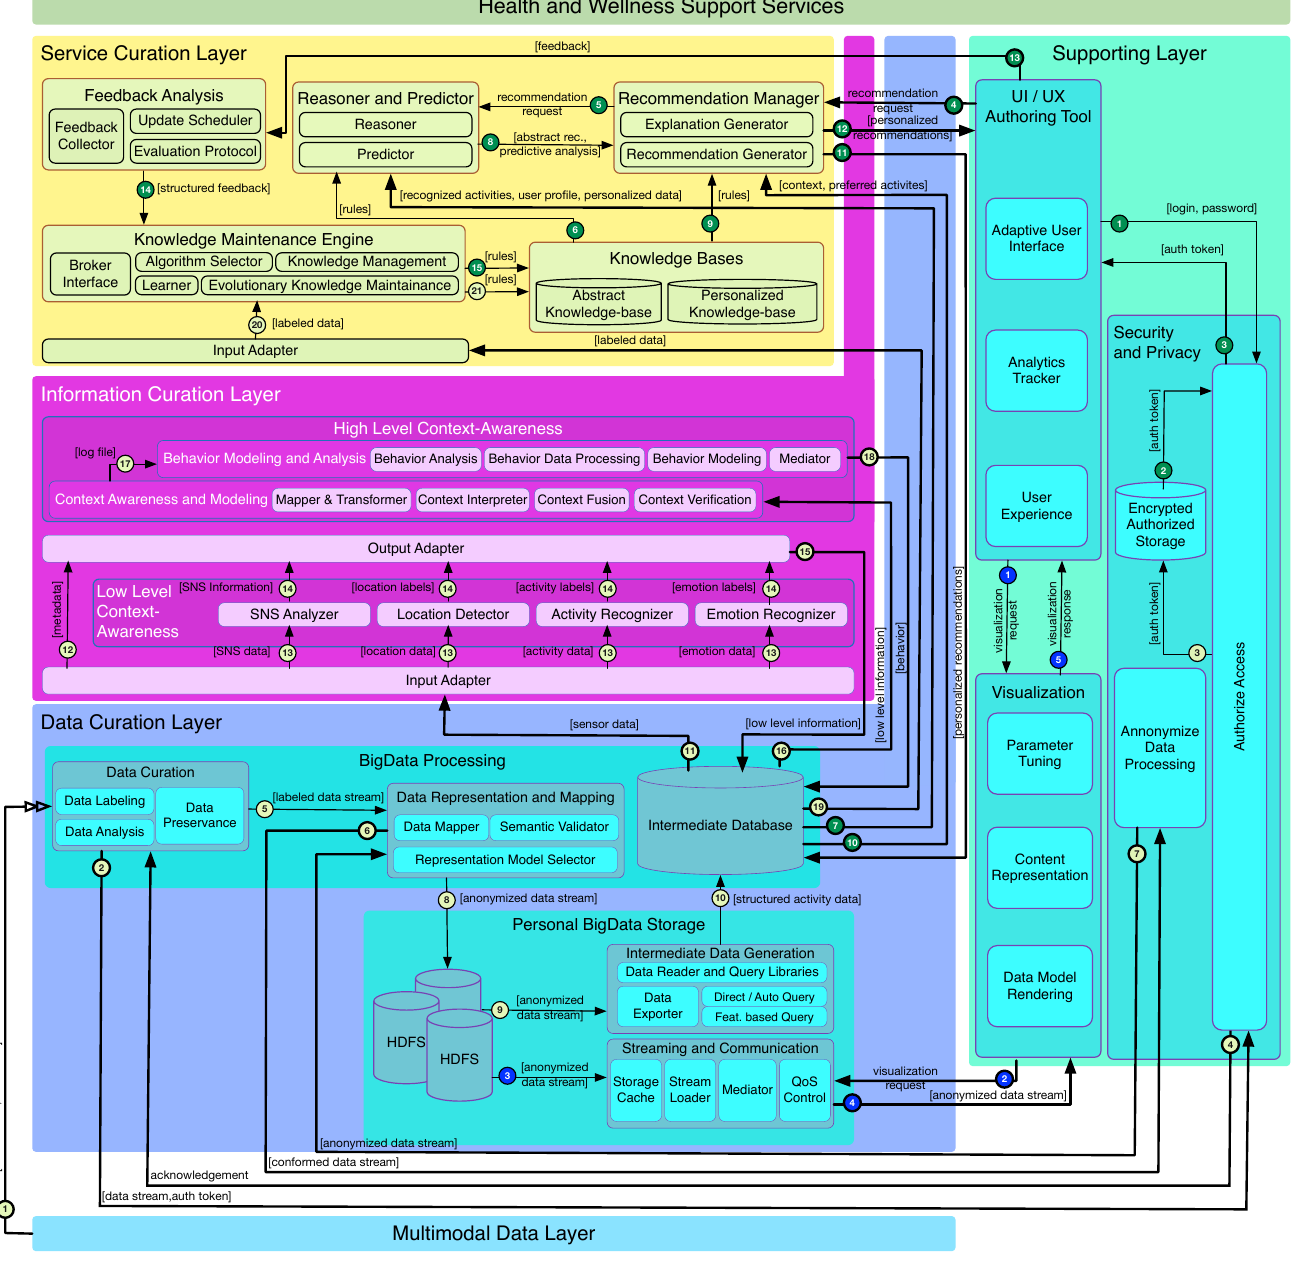
Fig. 1. Mining Minds Framework Architecture and Operational diagram.